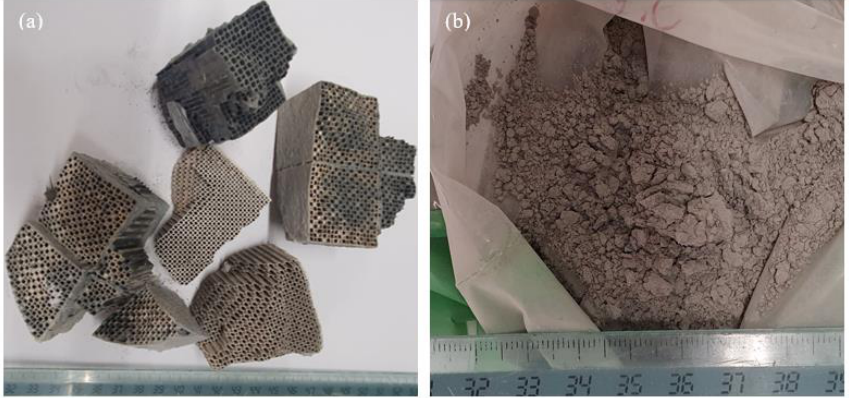
Figure 2. Spent automotive converter before ( a ) and after grinding (<500 µ m) ( b ).